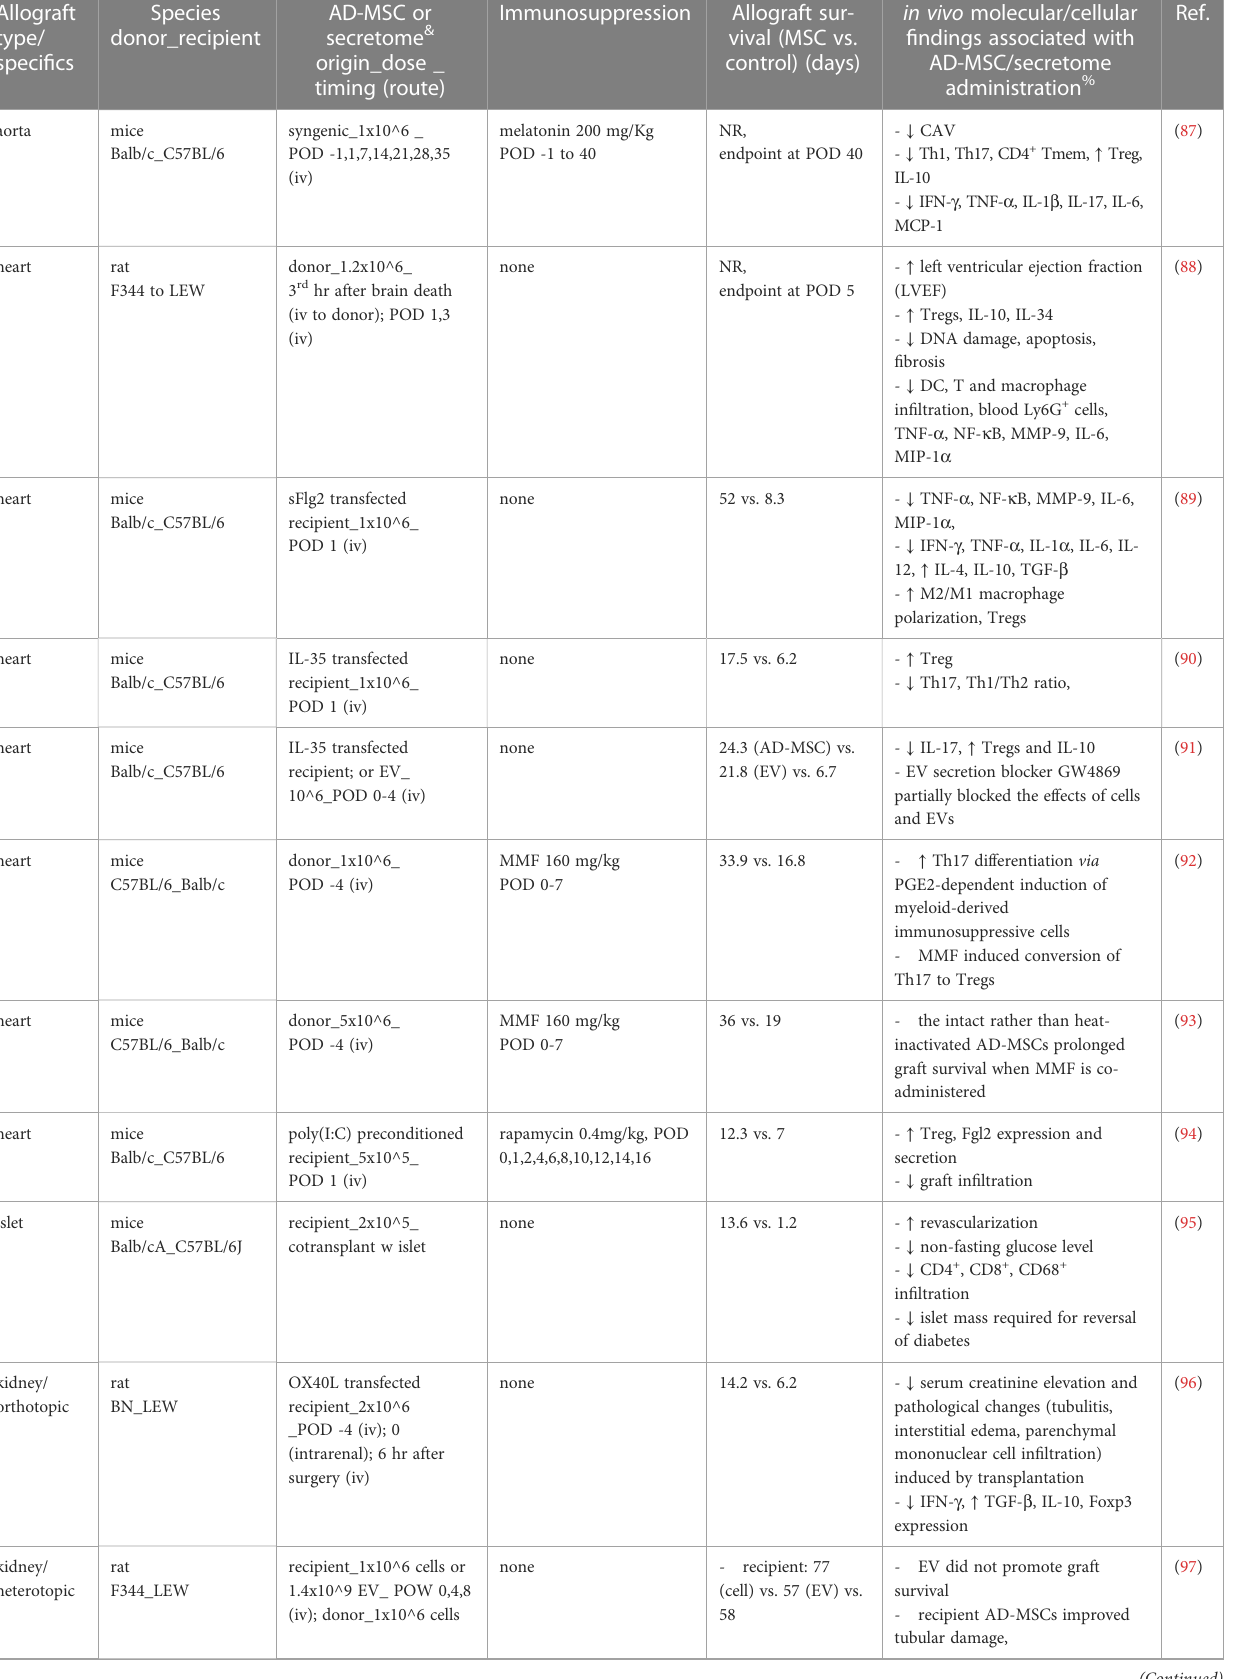
TABLE 1 Preclinical studies with AD-MSCs and secretome for peri-transplantation immunosuppression. Allograft